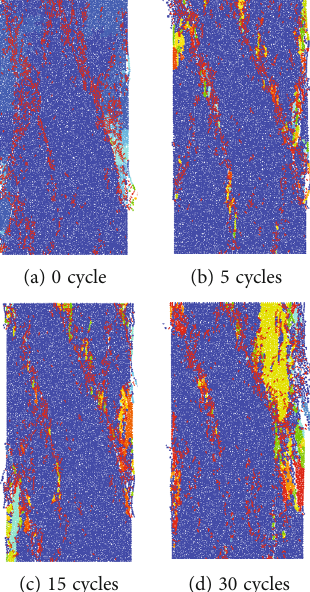
Figure 8: Microcrack propagation under di ff erent cycle